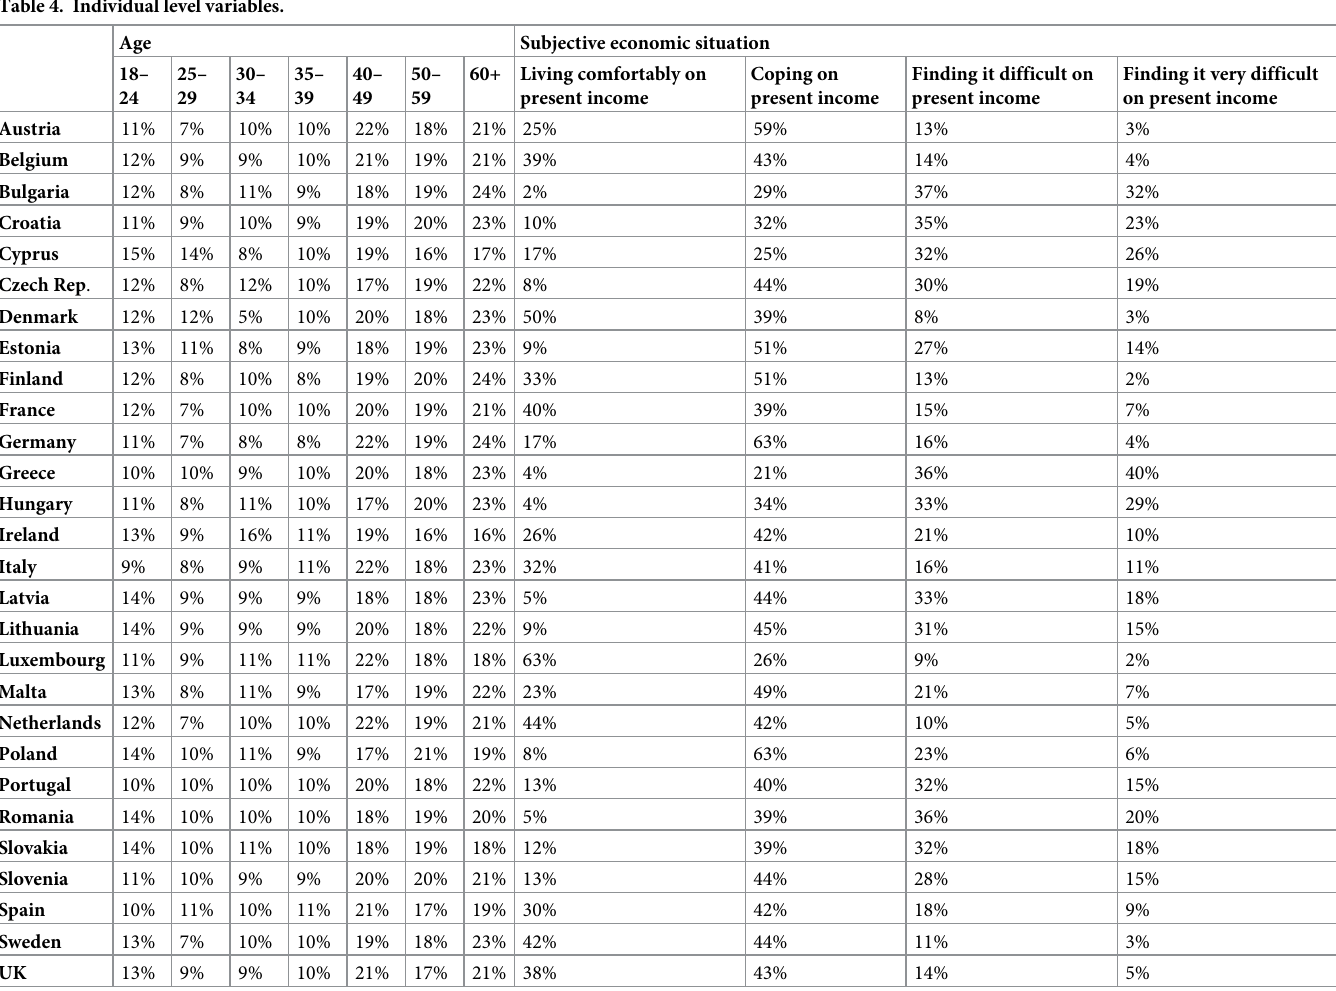
Table 4. Individual level